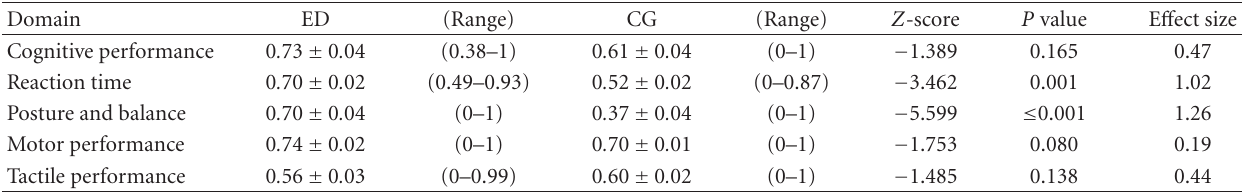
Figure 2: Performance of expert dancers (ED) and a matched control group (CG) for selected tests covering cognitive, posture and balance, motor, and tactile domains. Participants of the ED group showed (a) higher scores in the RSPM ( z = − 2 . 776, P = 0 . 006), (b) shorter Up and go times ( z = − 3 . 819, P ≤ 0 . 001), (c) less errors in the Aiming test for the right hand ( z = − 2 . 808, P = 0 . 005), and (d) lower 2 - Point-discrimination thresholds for the right index finger ( z = − 2 . 434, P = 0 . 015). Horizontal lines within the boxes represent the medians. Boxes show the top and bottom quartiles, and whiskers represent the minima and maxima within 1.5 interquartile range (IQR). Outliers ( > 3.0IQR) are labeled as solid dots. Table 2: Indices of performance (IP) averaged across individual tasks describing cognition, reaction times, posture and balance, and motor, and tactile performance for both